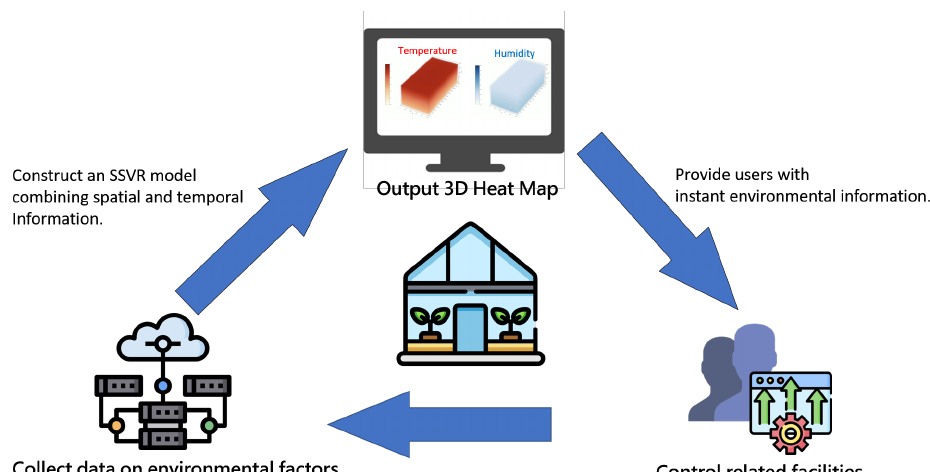
Figure 1. Continuous Monitoring and Decision